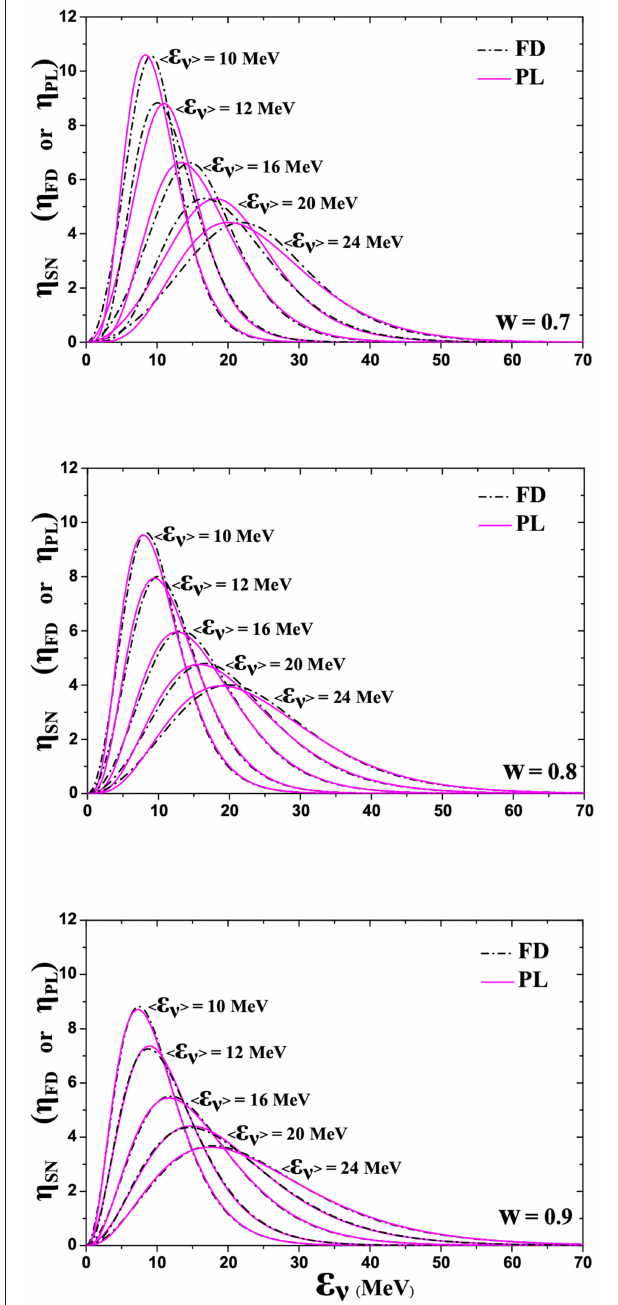
FIGURE 4 | Supernova neutrino energy spectra ( η SN ) coming out of the analytic expressions of: (i) the two-parameter Fermi-Dirac distribution (FD) and (ii) the two-parameter Power-law (PL) distribution (see Appendix ). The five sets of values of their parameters refer to equivalent distributions (for details see the